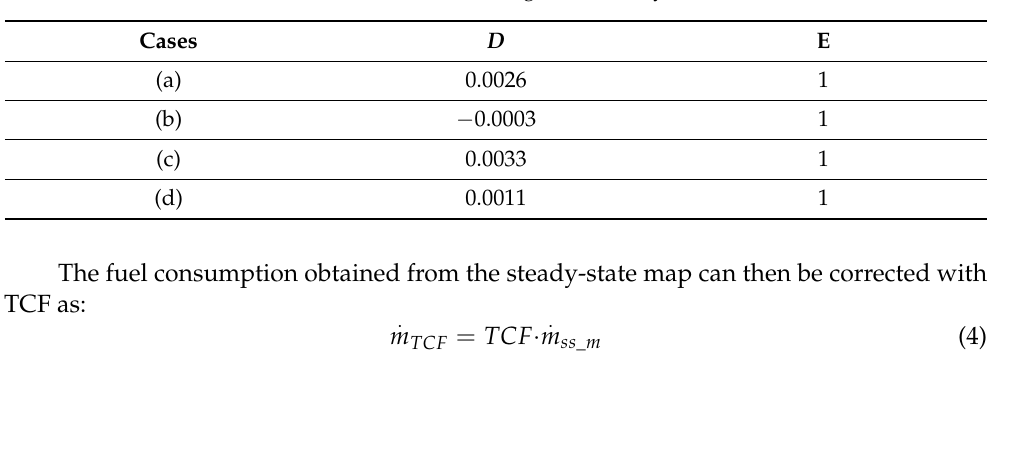
Table 3. The values of coefficient D obtained from regression